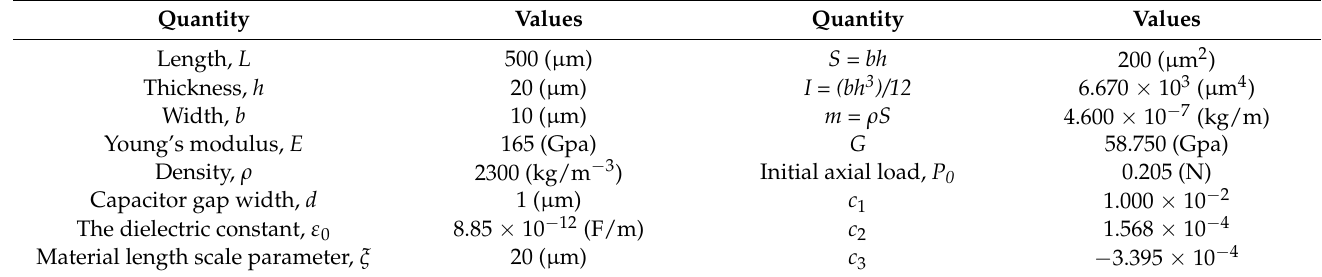
Table 1. Geometric and material parameters of MEMS resonator